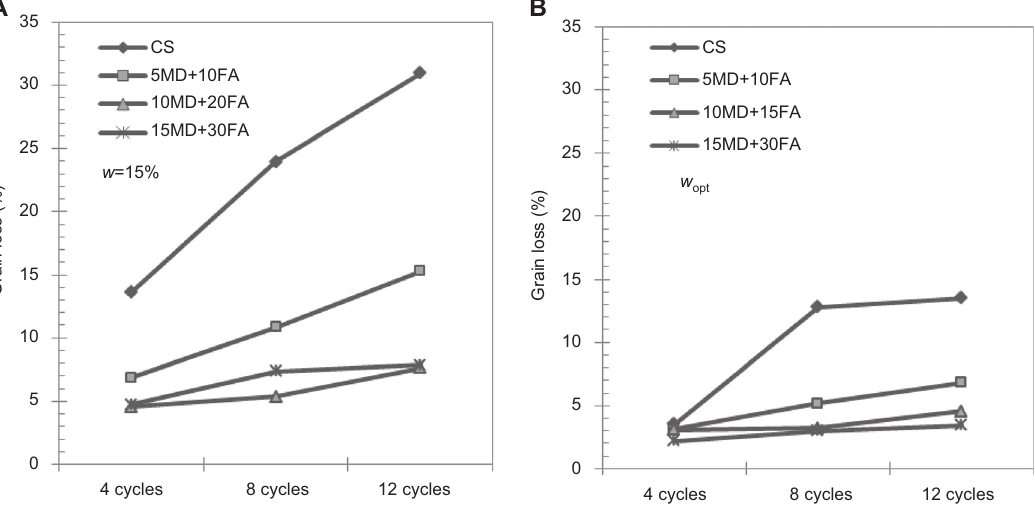
Figure 5 Relationship between grain loss and F-T cycles after the F-T cycles (A) at the specimens with prepared w = 15% and (B) at the specimens with prepared w opt